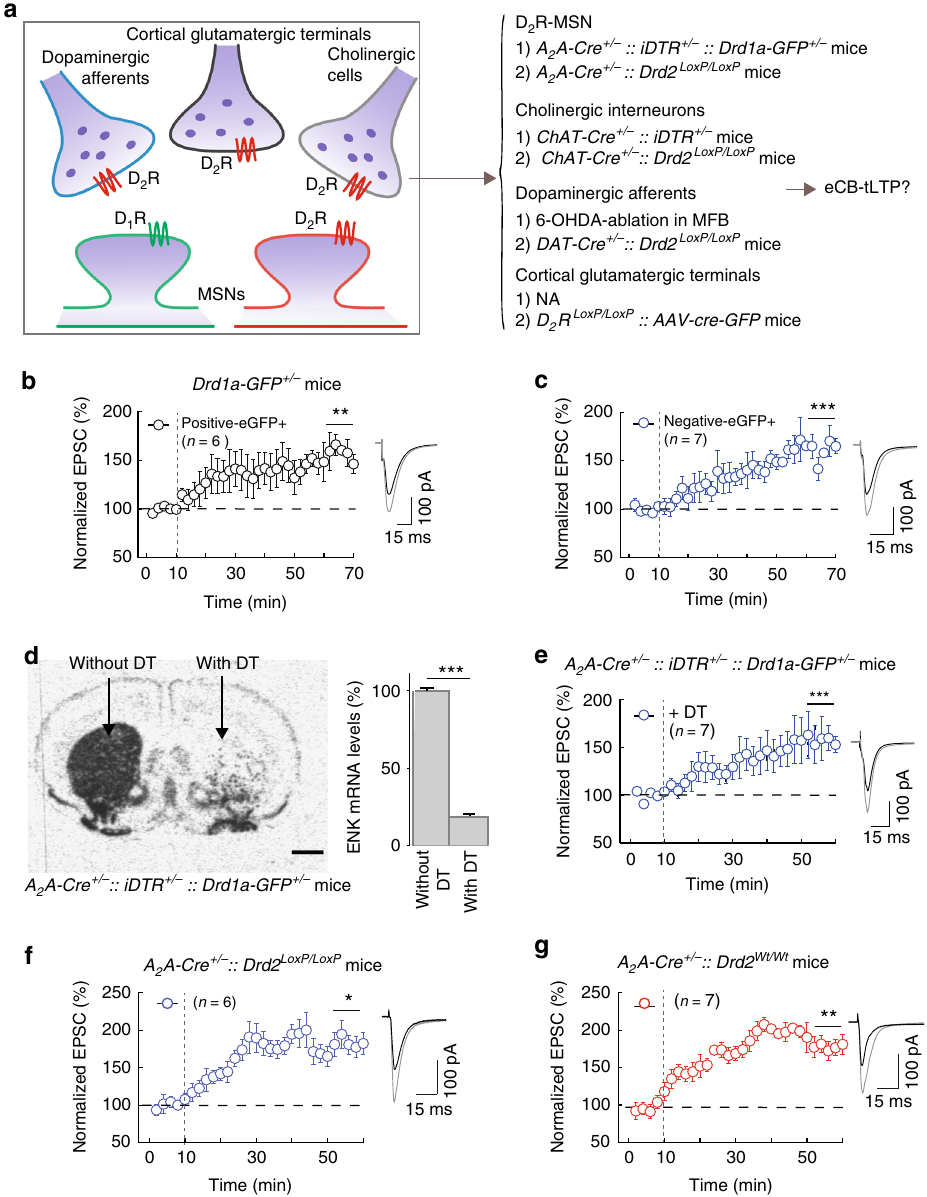
Fig. 4 eCB-tLTP does not depend on D 2 R expressed by D 2 R-MSNs. a Location of D 2 R in striatum expressed in striato-pallidal MSNs, cholinergic interneurons, SNc dopaminergic and cortical glutamatergic afferents. Right: the two complementary strategies to identify the D 2 R involved in eCB-tLTP: (1) genetic-ablation of D 2 R-MSN or cholinergic interneurons (using DTR and stereotaxic DT injection) and 6-ODHA-ablation of dopaminergic cells in the MFB, and (2) D 2 R-cKO in D 2 R-MSN, cholinergic interneurons, dopaminergic cells, or corticostriatal glutamatergic afferents; NA accounts for